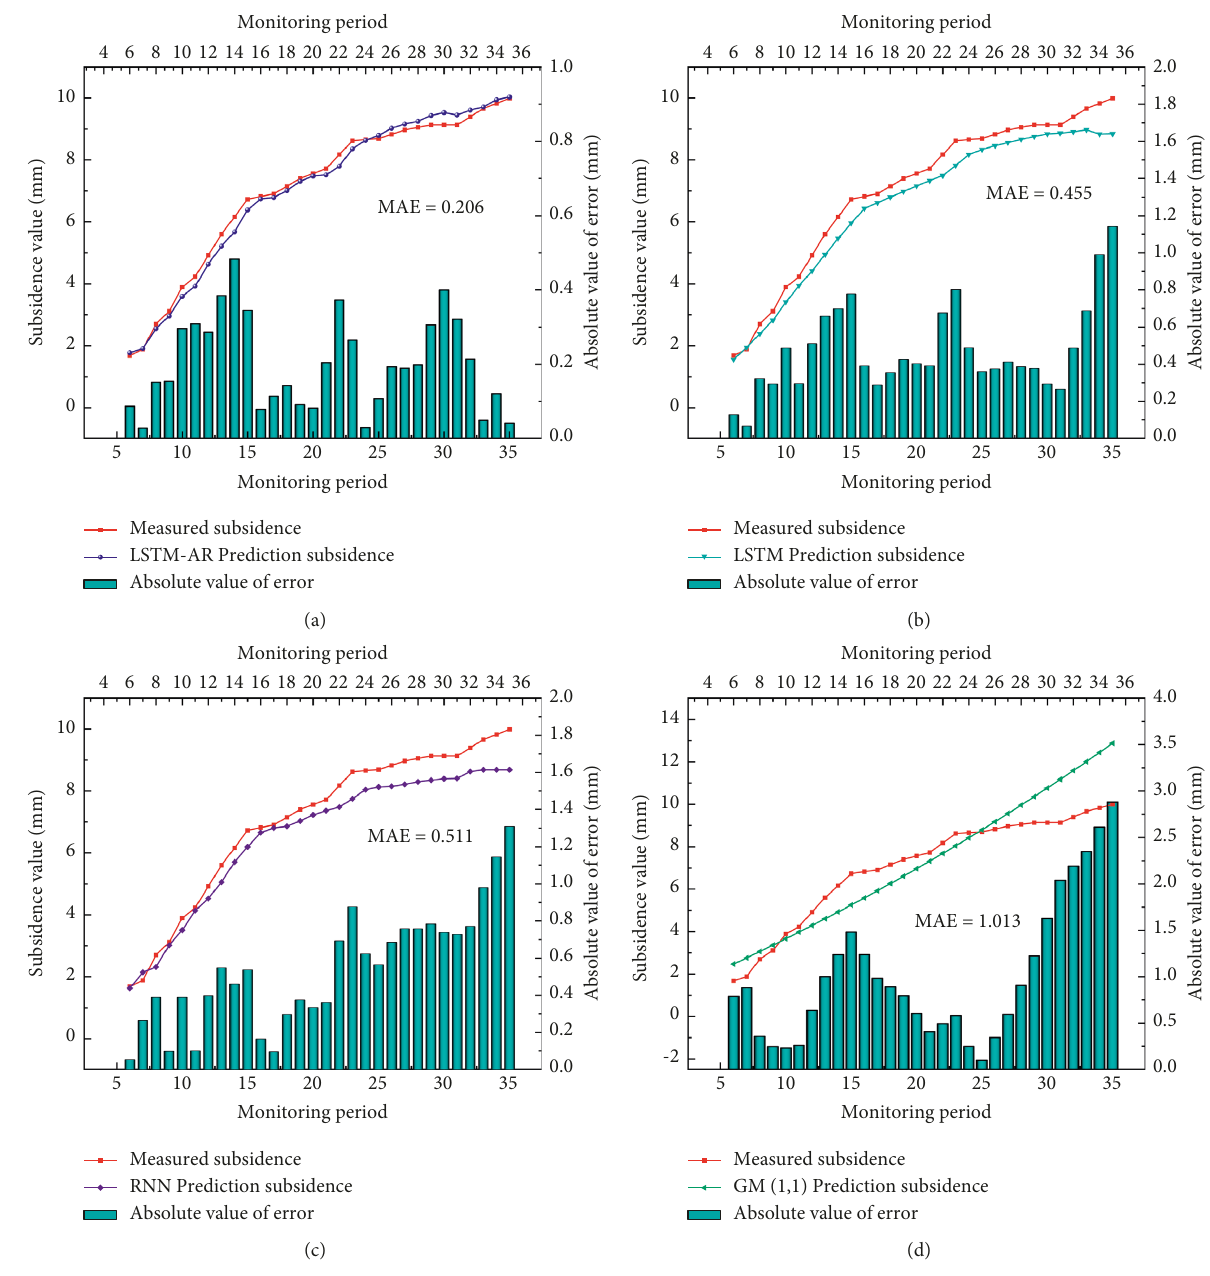
Figure 7: The absolute value of the error between the predicted value of the prediction model and the measured value. Table 8: The prediction accuracy of different